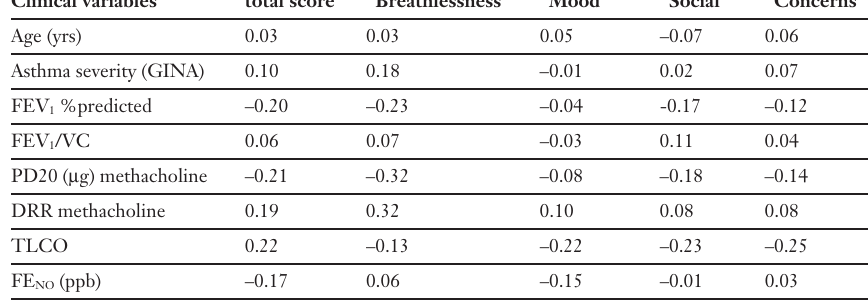
Correlation between AQLQ-Sydney scores and clinical data (n =